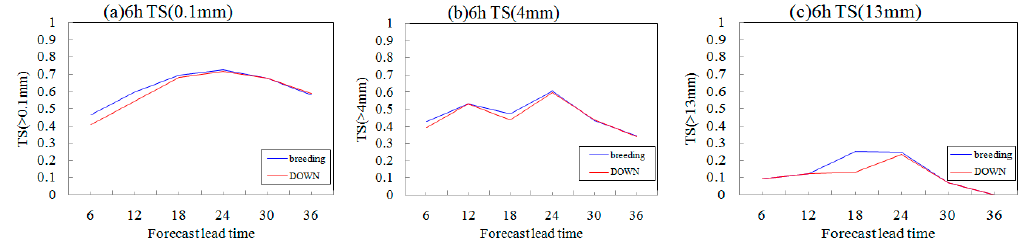
Figure 10. Threat score of the ensemble mean forecast 6 h accumulative precipitation for the Breeding ensemble and Down ensemble: ( a ) greater than 0.1 mm; ( b ) greater than 4 mm; and ( c ) greater than 13 mm.